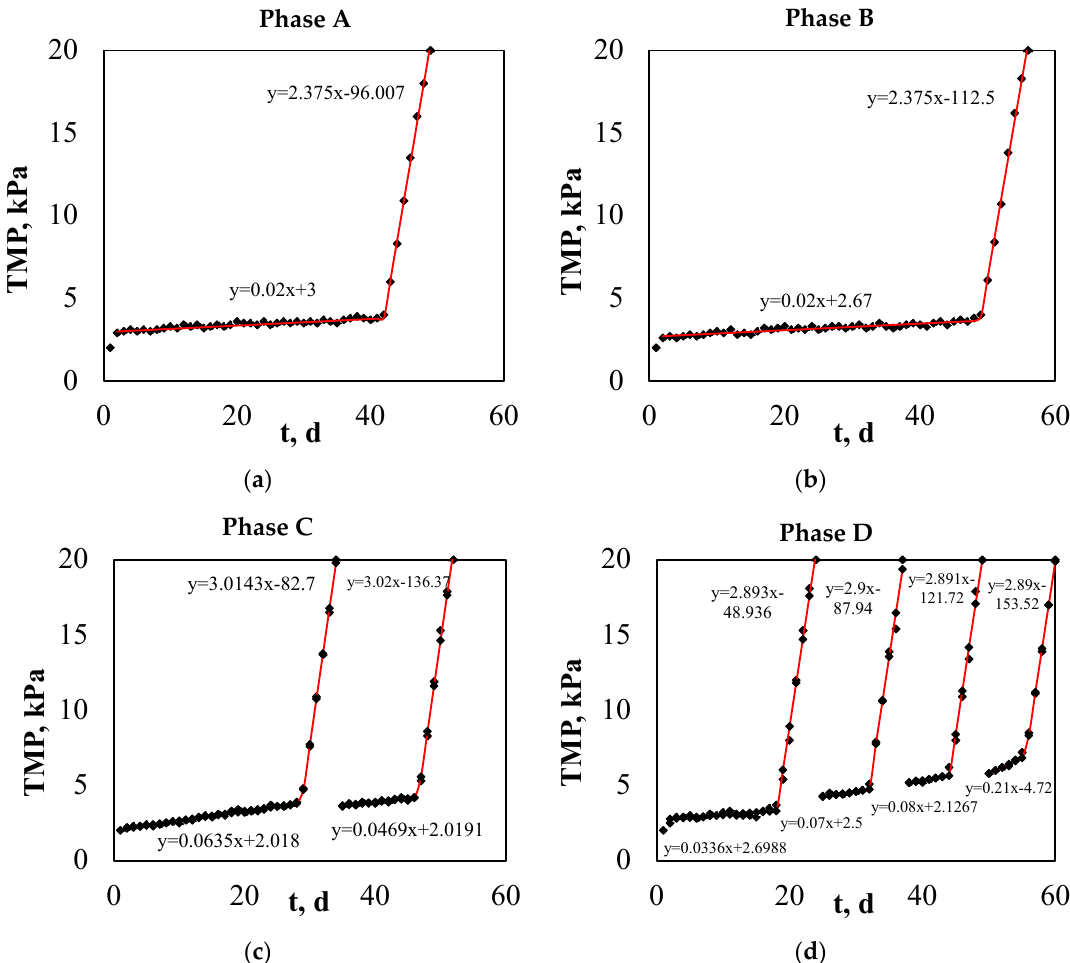
Figure 8. Experimental and theoretical TMP evolution during: ( a ) Phase A; ( b ) Phase B; ( c ) Phase C; ( d ) Phase D.